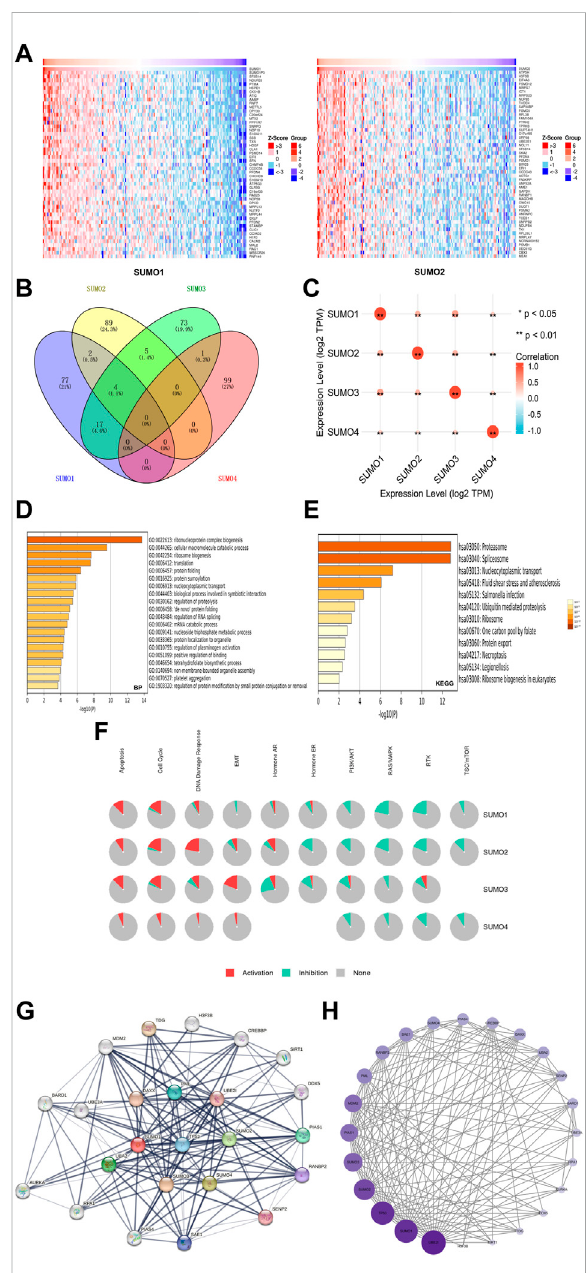
FIGURE 4 Gene enrichment analysis and PPI network construction of SUMO family in PAAD. (A) Top 50 genes co-expressed with SUMO1/2; (B) The venn diagram of SUMO family members and their400co-expressedgenes; (C) SUMOfamilymembersare also co-expressed among themselves. *, p < 0.05; **, p < 0.01; (D) The GO enrichment of the BP terms of the SUMO family and its 400 co-expressed genes; (E) The KEGG enrichment of the SUMO family and its 400 co-expressed genes; (F) SUMO family played an activating role in a variety of oncogenic pathways; (G,H) TP53 played an important role in PPI network which was closely related to SUMO